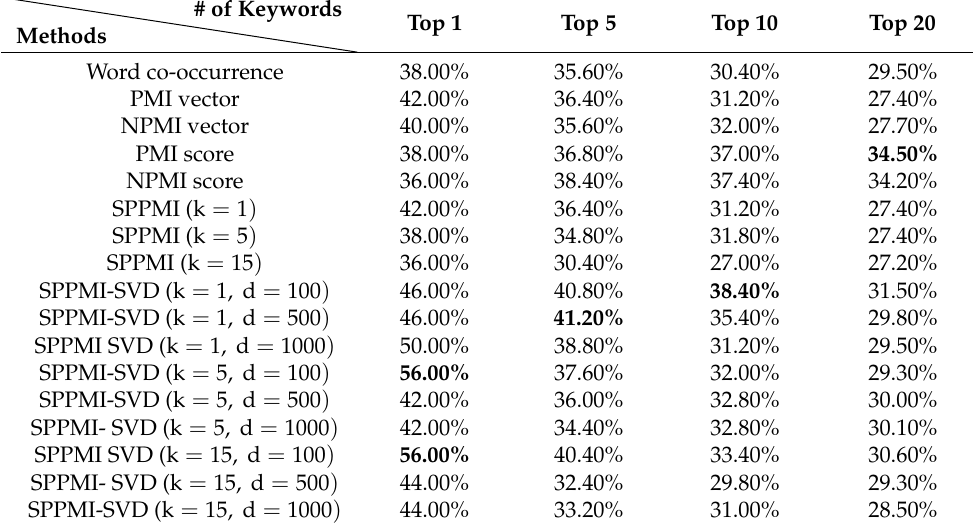
Table 3. Comparison of precision between SPPMI-based keyword expansion and five baseline models (word co-occurrence, PMI vector, NPMI vector, PMI score, and NPMI score). The values of d represent the number of singular values used in the SVD or the dimension of word vectors in word2vec. The values of c indicate the context size used in training